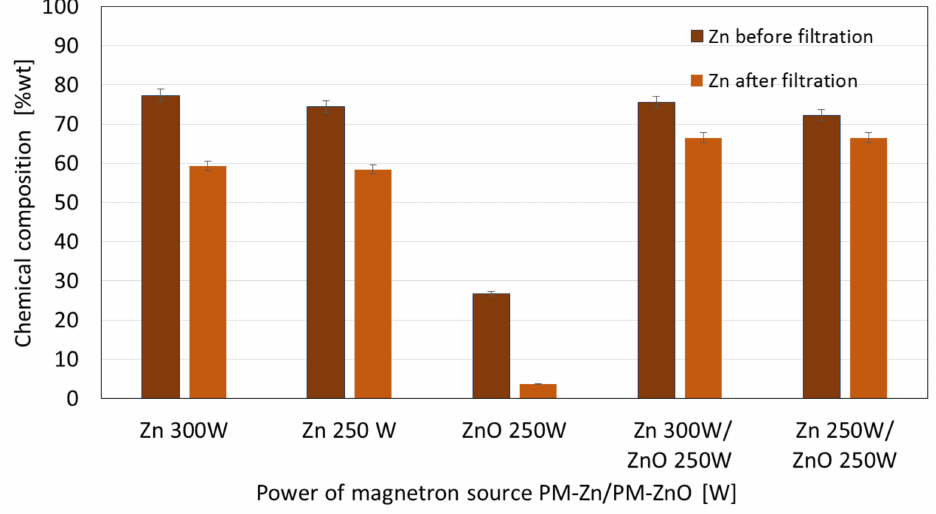
Figure 10. The comparison of the chemical composition (% wt.) before and after filtration for one- component Zn and ZnO coatings and two-component Zn/ZnO coatings deposited by a different magnetron power